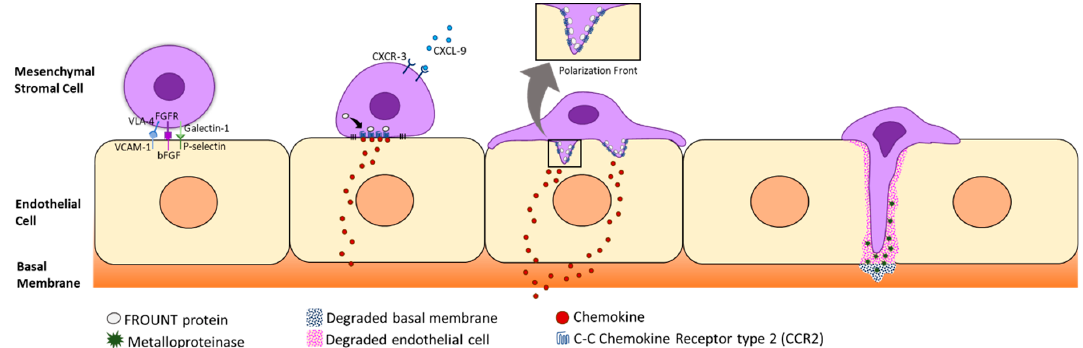
Figure 2. Transendothelial migration through the endothelial cells of the endothelium. Mesenchymal stromal cells (MSCs) develop a front pole through the joint action of the FROUNT protein and the C-C chemokine receptor type 2 (CCR2) in order to degrade endothelial cells and its basal membrane on its way to the damaged site.